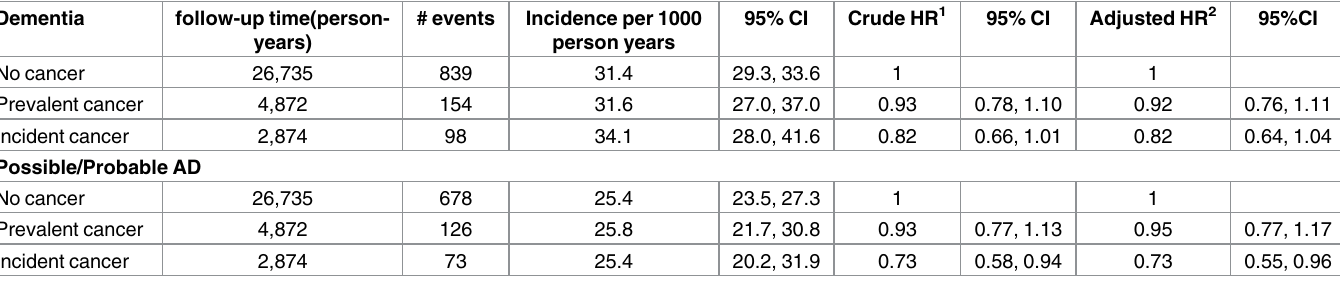
Table 3. Risks of dementia and AD after a cancer diagnosis among ACT study participants. This table shows follow-uptime, dementiaand AD inci- dence, and crude and unadjusted risks of dementiaand AD for prevalentand incident cancers. Abbreviations include:ACT (Adult Changesin Thought); AD (Alzheimer’s disease); CI (confidence interval); and HR (hazard ratio).